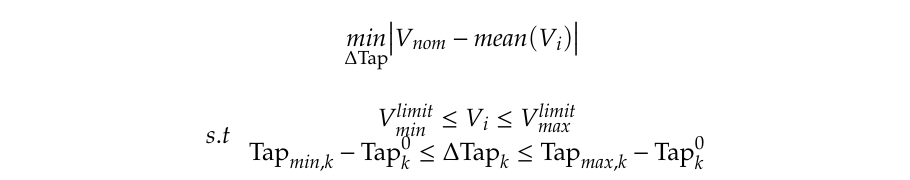
Figure 12. Voltage variation by tap changing device.